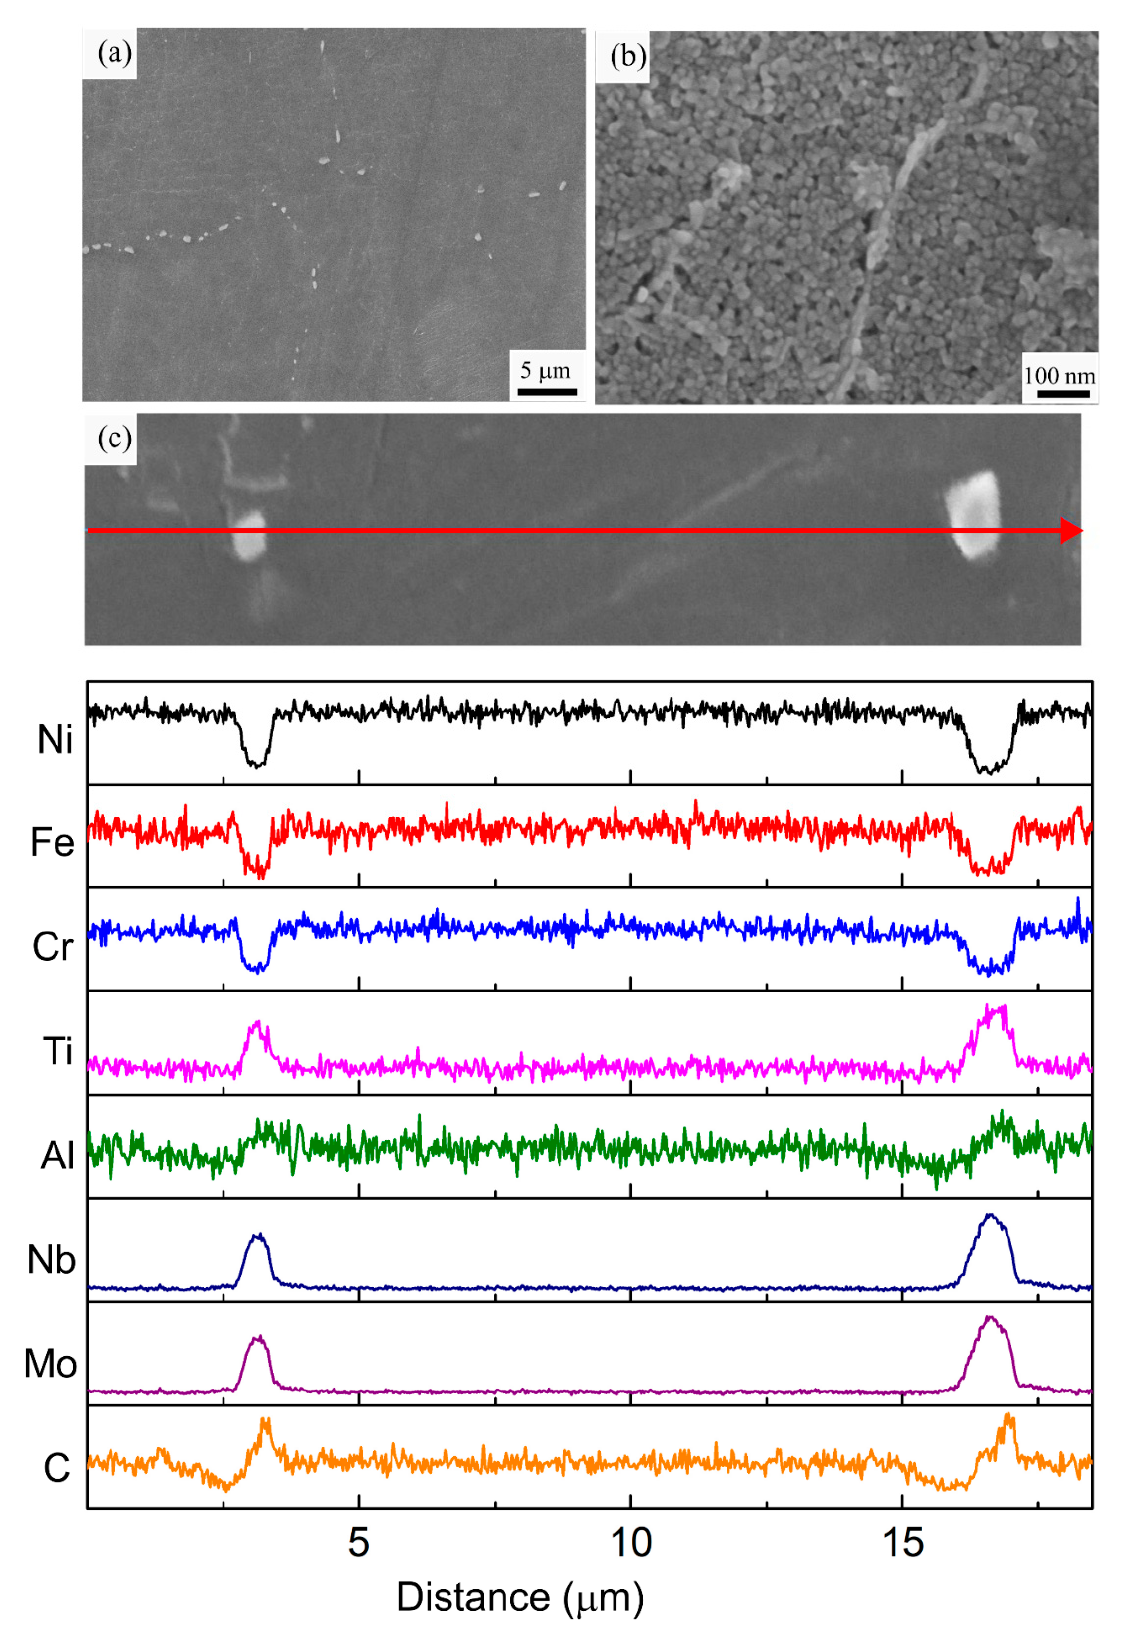
Figure 9. ( a , b ) Representative SEM micrographs, ( c ) EDS line scan analysis of the HT2 specimen along the marked red arrow.